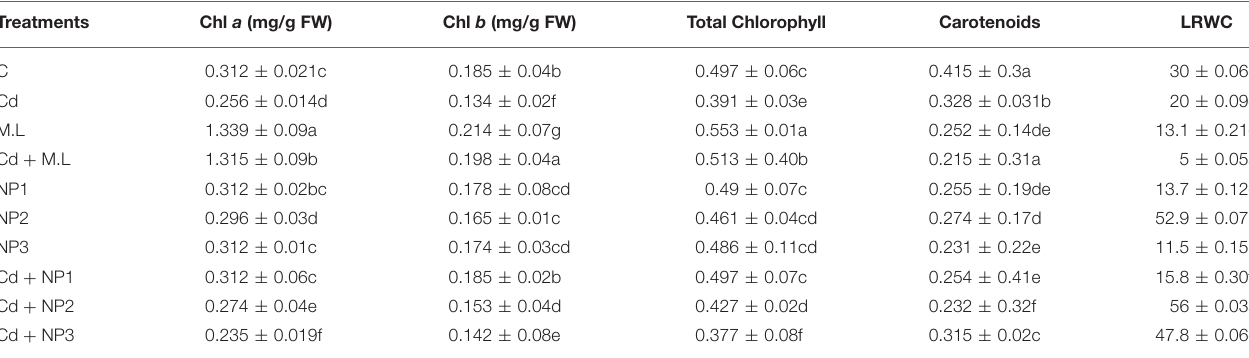
TABLE 2 | Effects of MZnO nanoparticles (NPs) on Chl a , Chl b , total chl, carotenoids, and leaf relative water content under Cd stress in linseed.